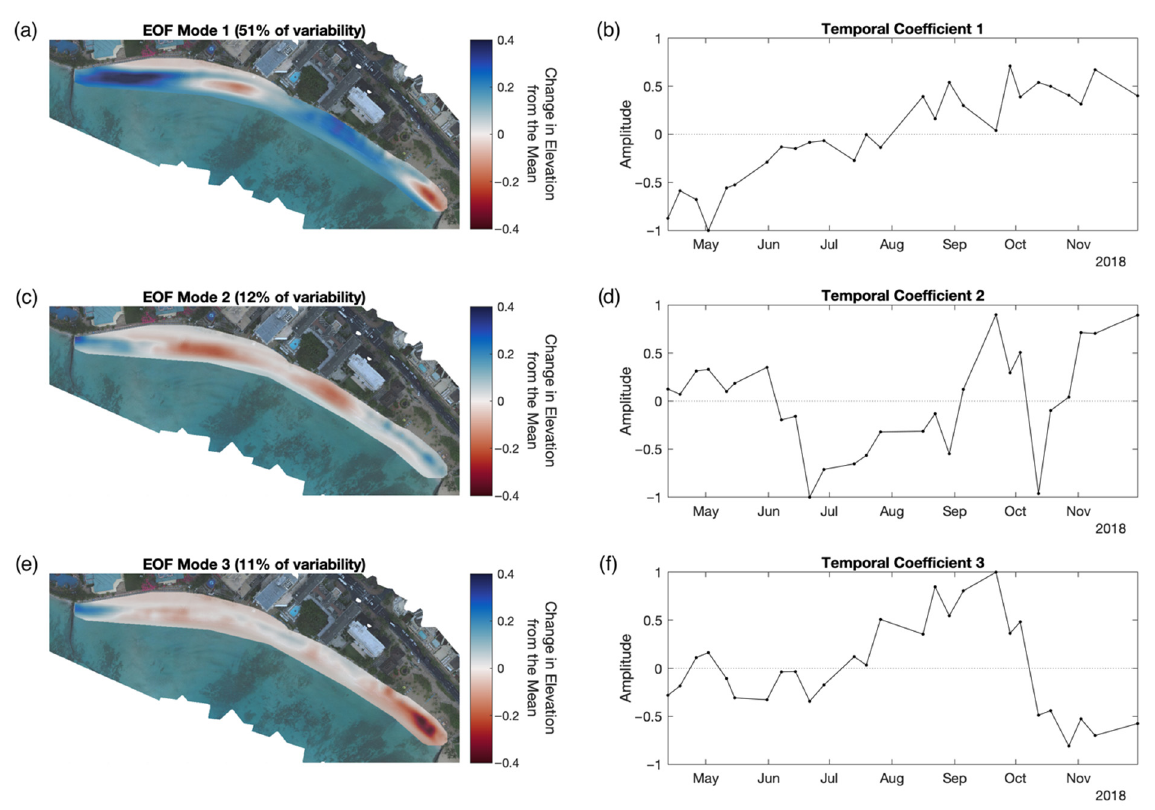
Figure 8. The first three spatial modes ( a , c , e ) and their respective temporal coefficients ( b , d , f ) of the EOF analysis, representing 74 percent of the variability of the study area during the study period. We interpret vertical changes in beach topography as inflation (accretion, blue) and deflation (erosion, red) when coupled with a positive temporal coefficient (above the dotted line), and the opposite (erosion, blue; accretion, red) when coupled with a negative temporal coefficient (below the dotted line).